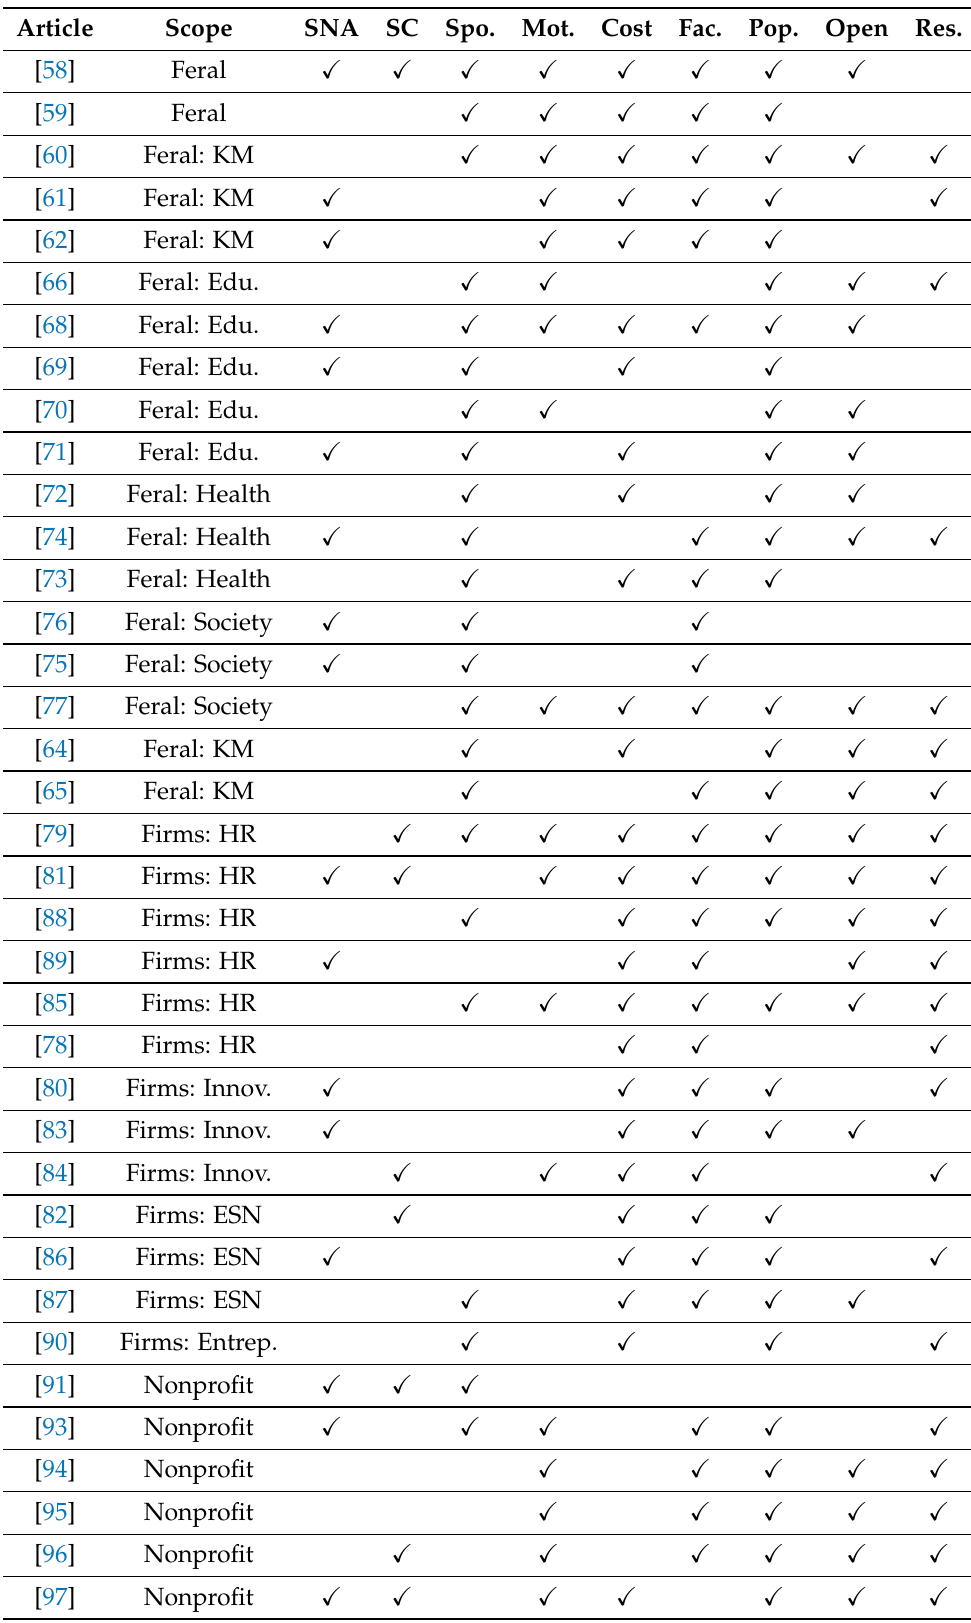
Table 1. Comparison among the analyzed